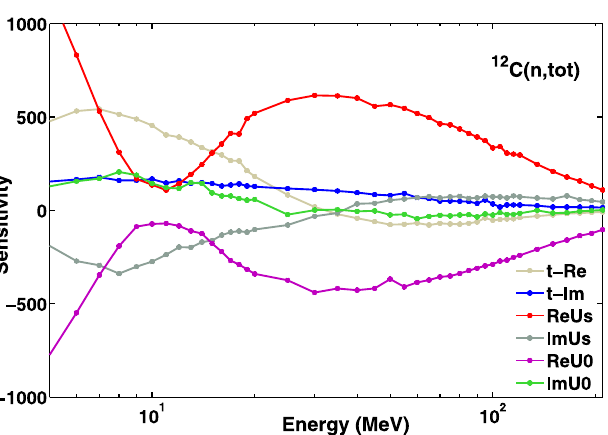
Fig. 4. The sensitivities of six parameters to the 12 C(n,tot) cross sections.